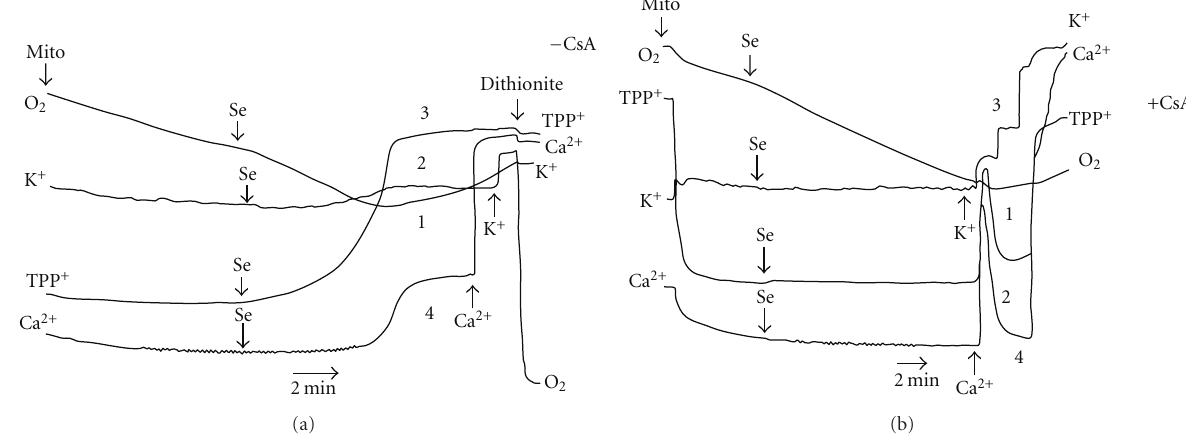
Figure 6: Simultaneous recordings of four mitochondrial parameters (respiration, ΔΨ mito , K + , and Ca 2+ fluxes) with the help of O 2 , TPP + , K + , and Ca 2+ -selective electrodes after treatment of isolated RLM with sodium selenite in the absence (a) or presence of CsA (b). The additions of Na 2 SeO 3 (5 µ M) are indicated by arrows. The remainder is as in Figure 5.